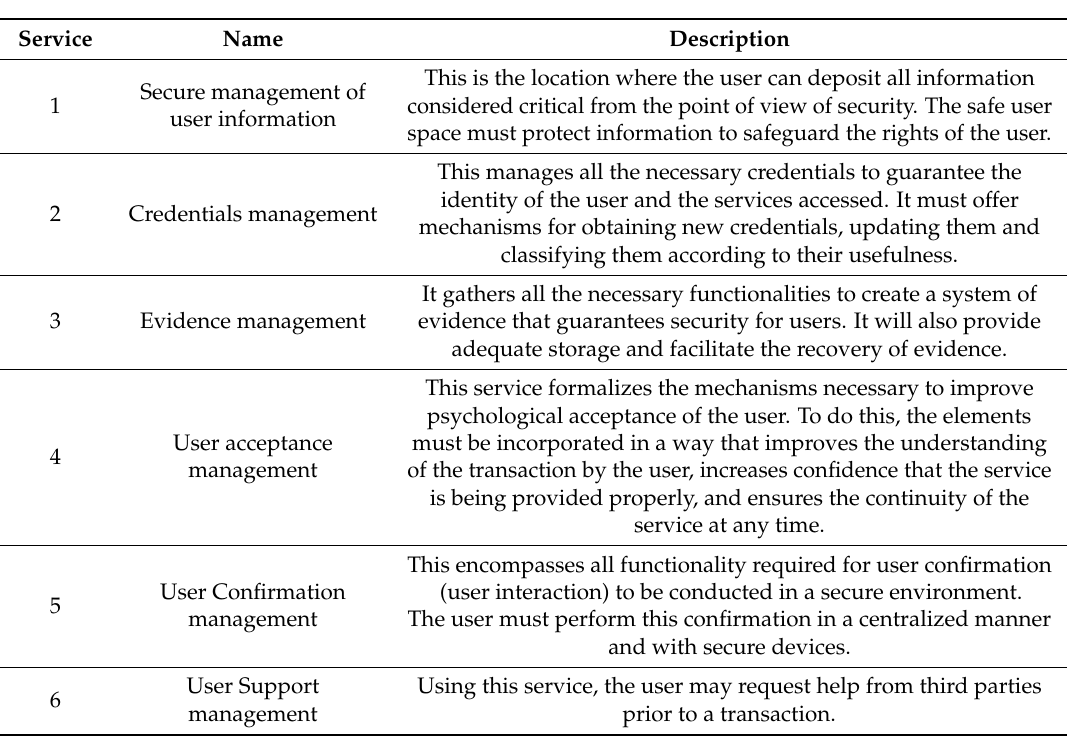
Table 1. Description of the services that comprise the reference